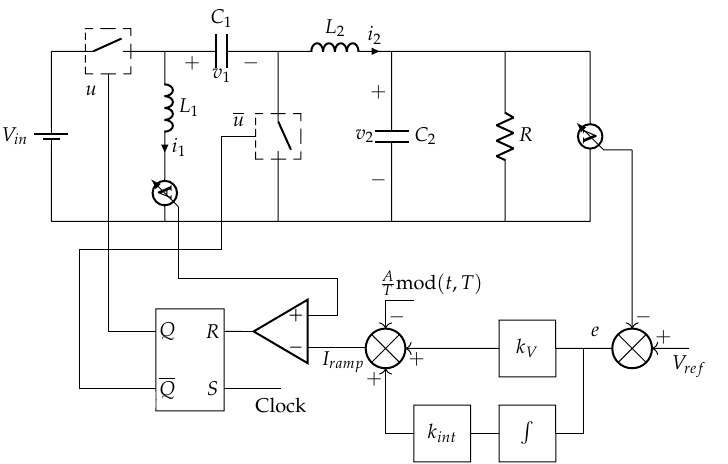
Figure 1. Schematic representation of the synchronous ZETA converter controlled via ramp